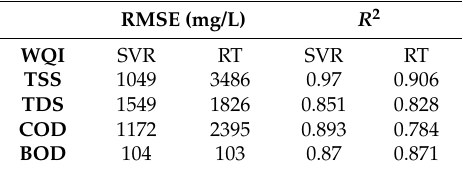
Table 2. Comparison between SVR and RT by means of RMSE and R 2 .